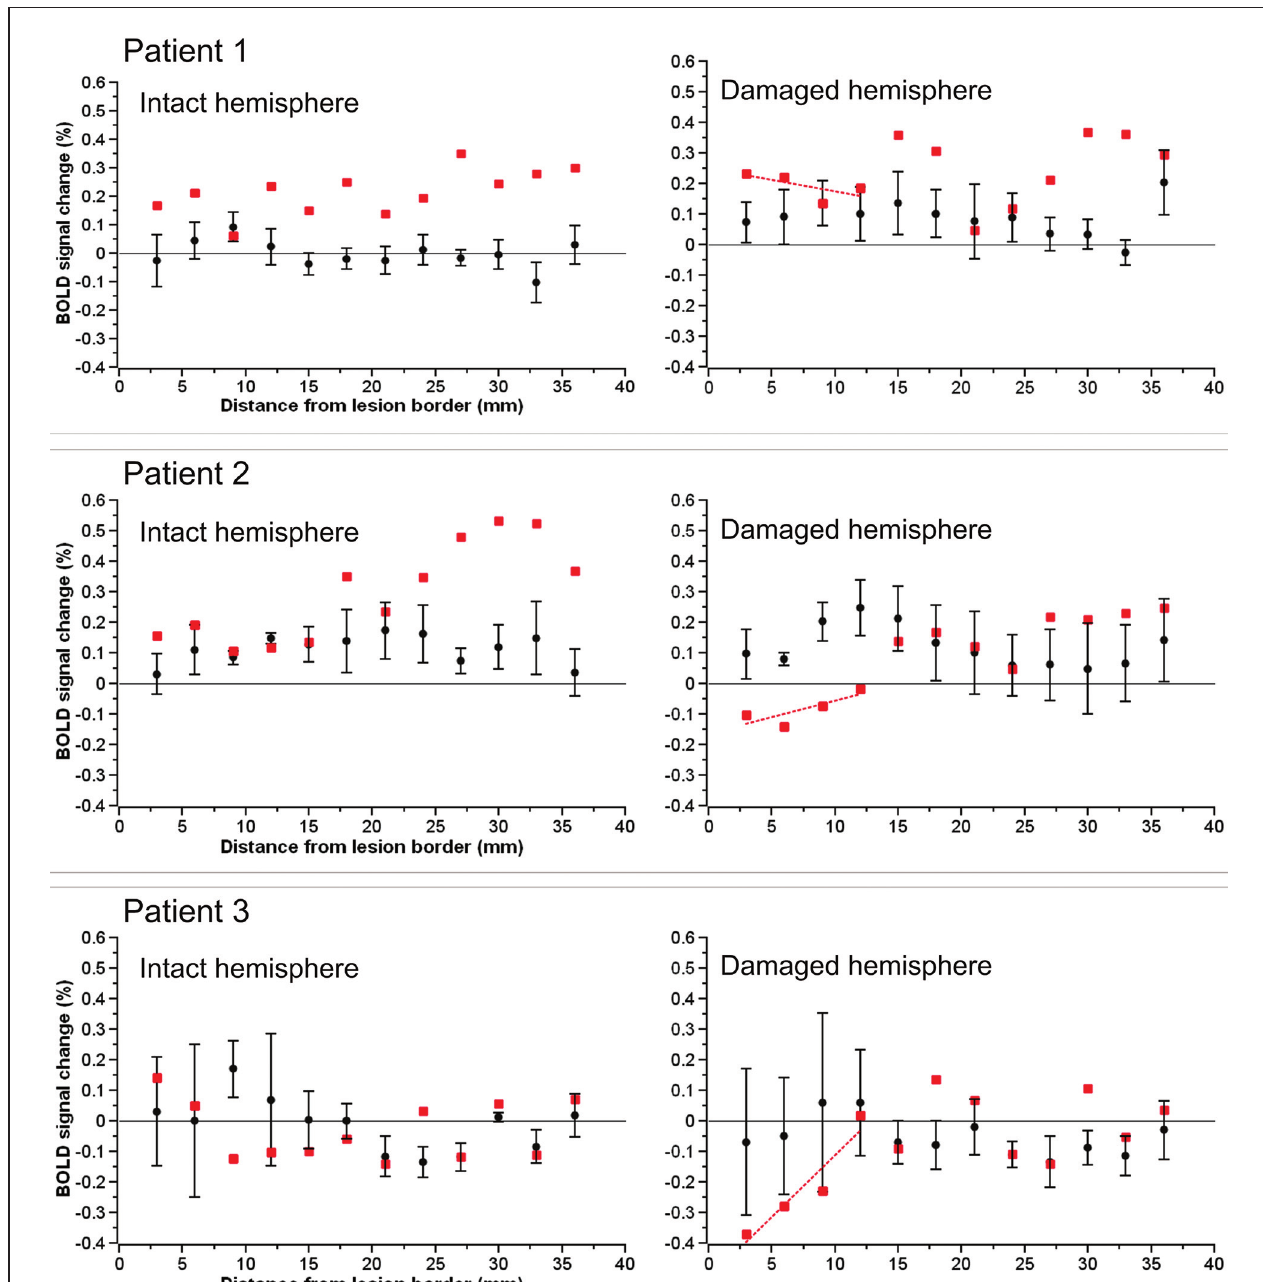
data for the left hemispheric perilesional regions and the images on the right the data for the right hemispheric perilesional regions. Error bars reflect standard error of the